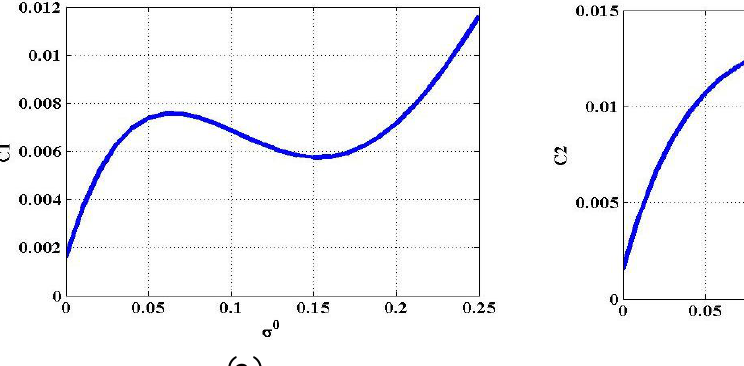
and ( b ) c used to retrieve wind 1 2